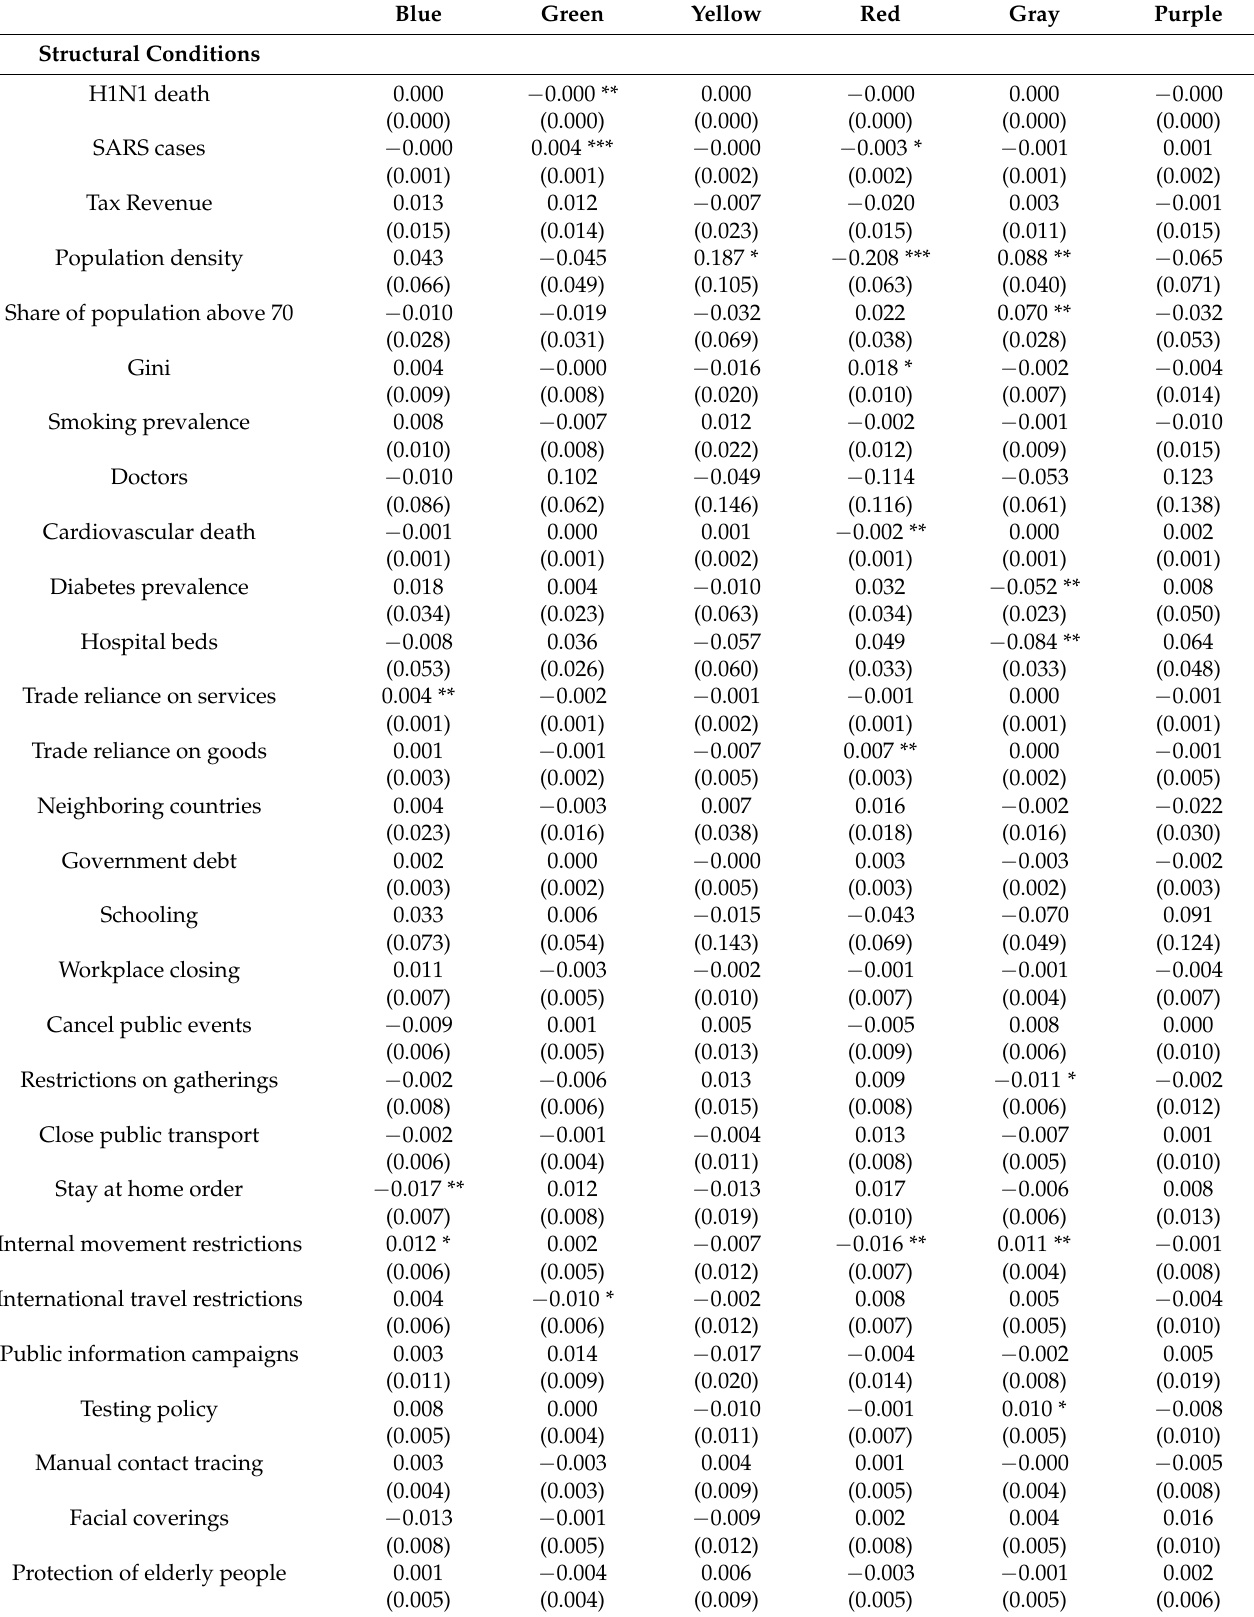
Table 3. LPM: COVID-19 outcomes on structural conditions and policy